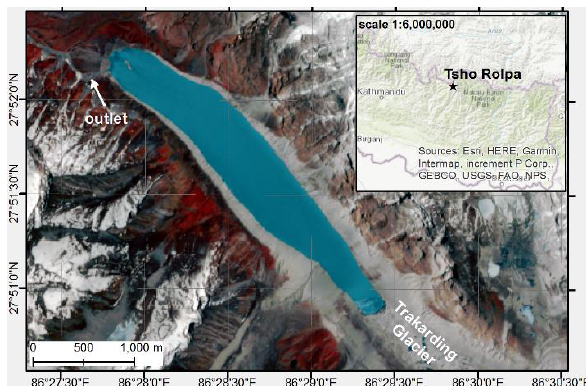
Figure 1. Tsho Rolpa Glacial Lake overview using a false colour infrared composite from Sentinel-2 acquired on 18-05- 2019. Inset map shows the location of the lake in Nepal.